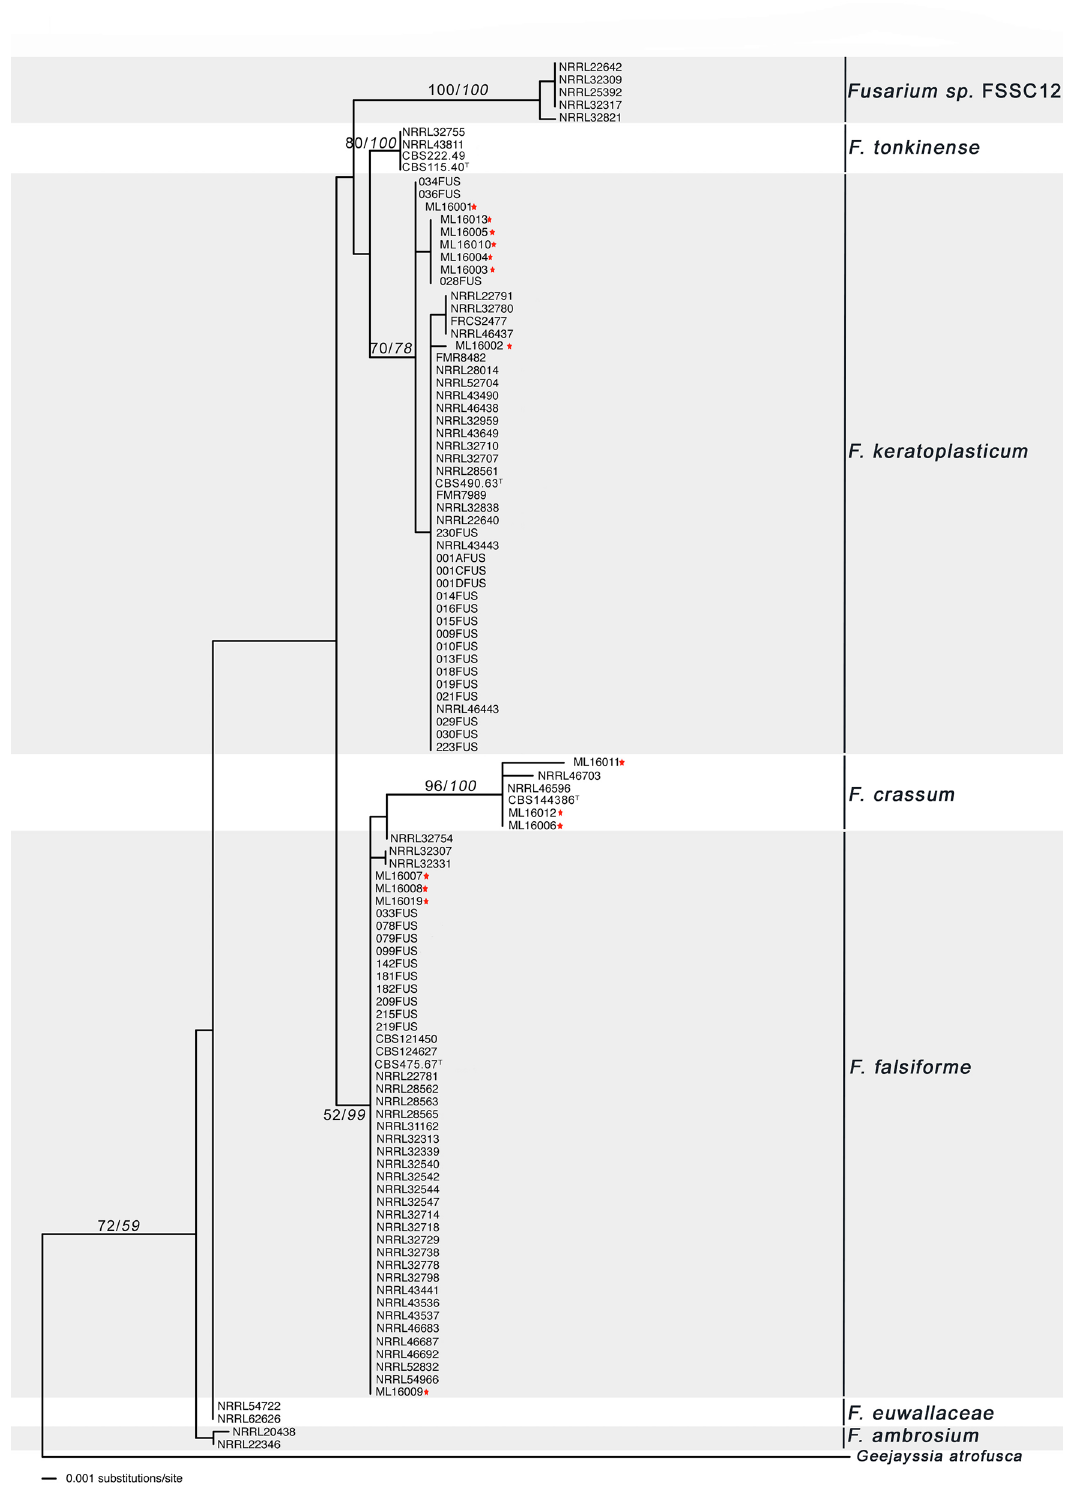
Figure 3. Maximum likelihood analysis of Fusarium species isolates from other marine animals based on two loci, large subunit (LSU) and internal transcribed standard (ITS). Numbers within the tree represent the bootstrap values of 1 000 replicates, followed by the posterior probability (italics). Strains isolated during this study are marked with a red asterisk